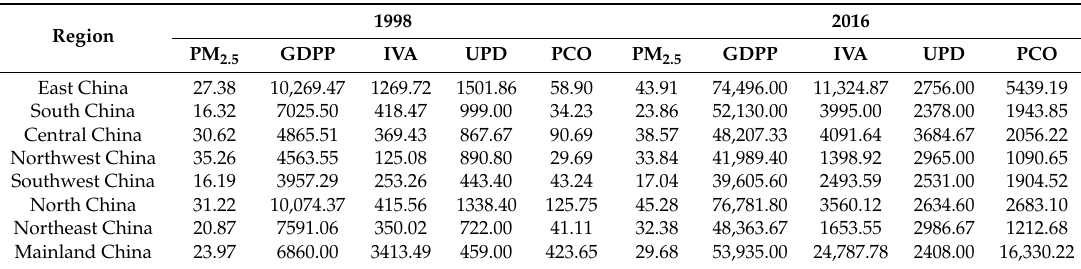
Table 1. The values of GDP per capita (GDPP) (yuan/person), industrial added values (IVA) (billion yuan), urban population density (UPD) (person/per square kilometer), private car ownership (PCO) (10 4 cars) and PM 2.5 ( µ g/m 3 ) in 1998 and 2016.